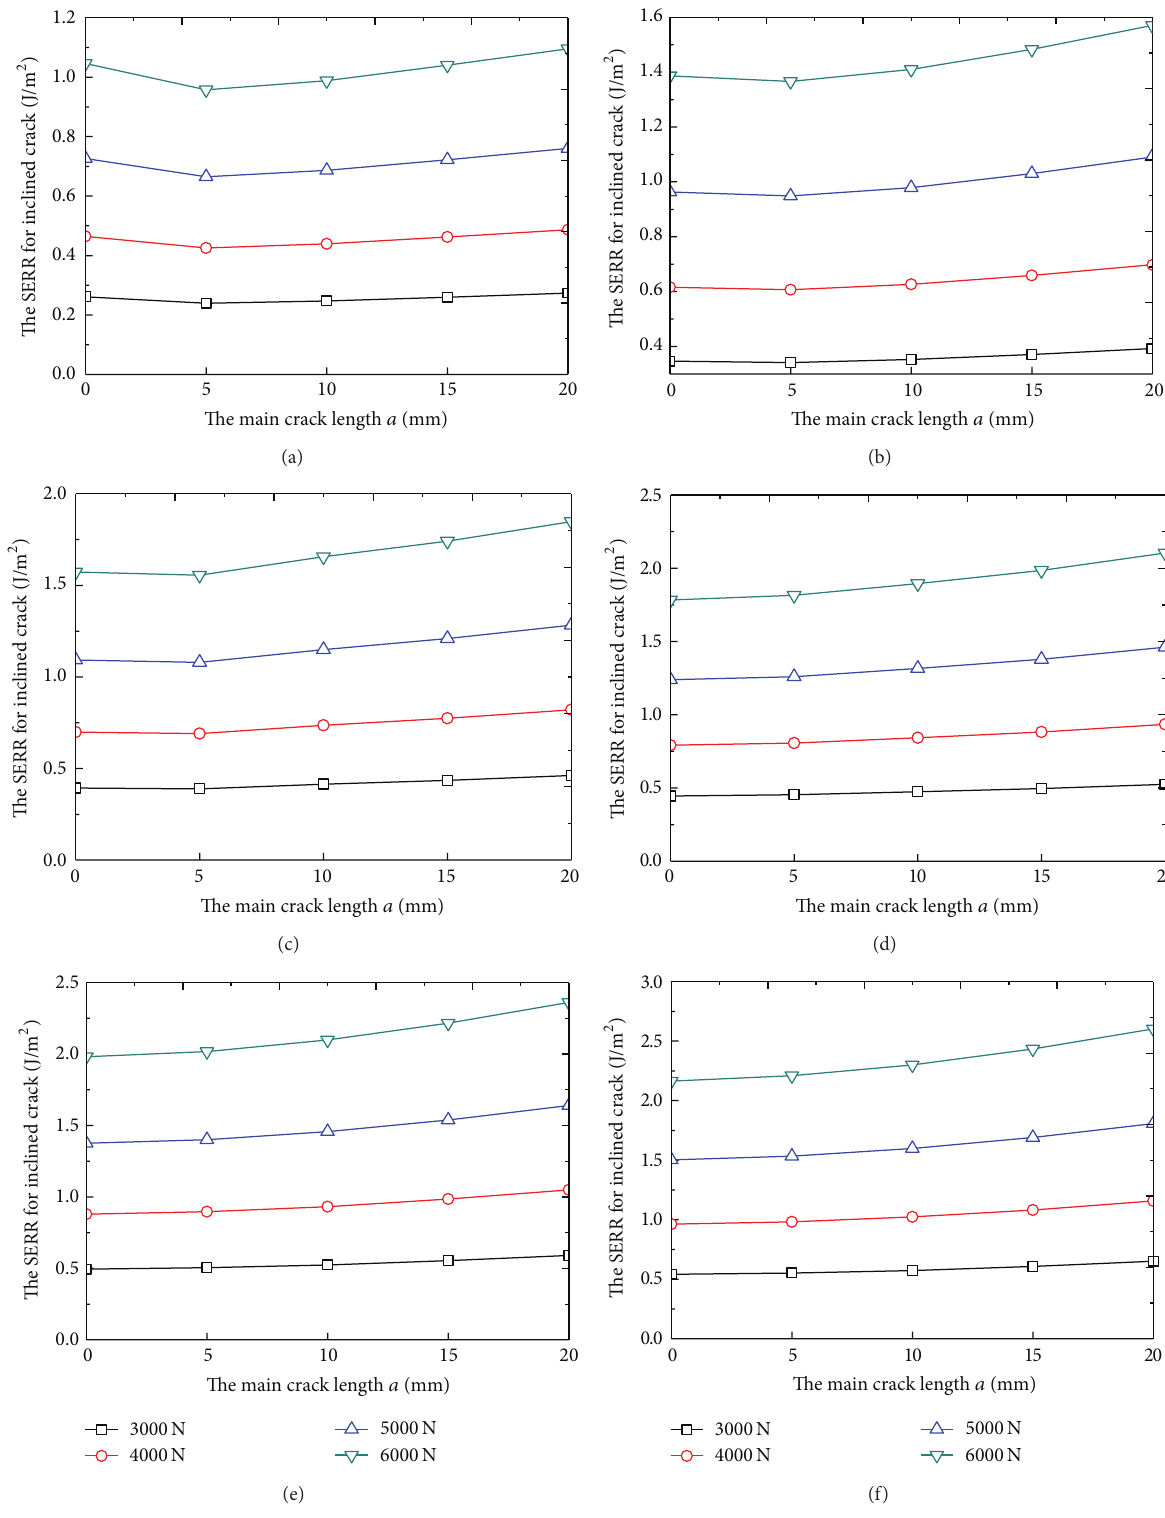
Figure 13: The plot of SERR against main crack propagation for various length of inclined crack. (a) 0mm of inclined crack length, (b) 1mm of inclined crack length, (c) 1mm of inclined crack length, (d) 2mm of inclined crack length, (e) 3 mm of inclined crack length, and (f) 0mm of inclined crack